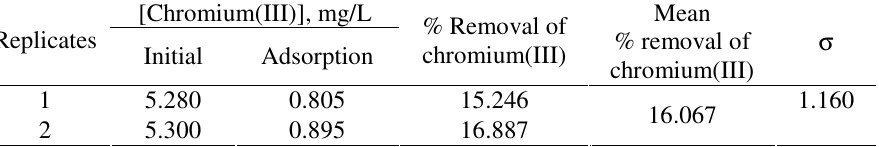
Table 1. Percentage removal of Chromium(III) in water